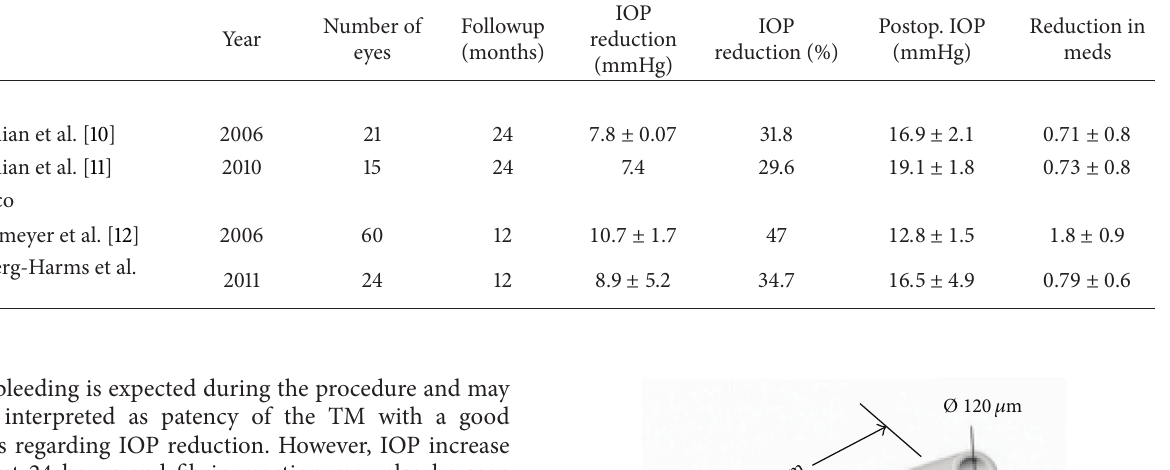
Table 4: ELT study results.